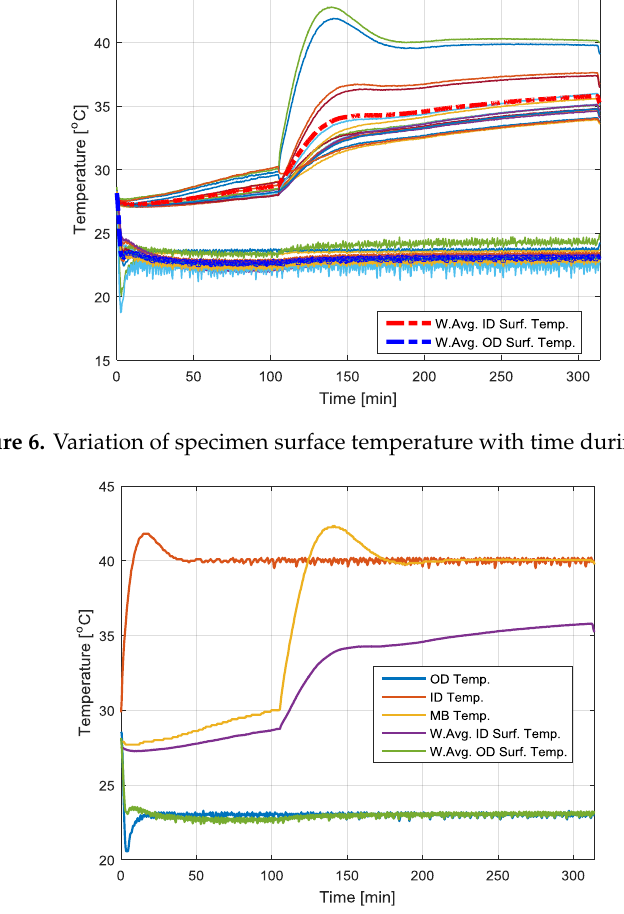
Figure 8. Thermal transmittance of Wall System 1 as a function of the wall mean temperature . ii. Wall System 2 Table 4 shows the results for Wall System 2. As shown in Figure 3b, the wall was composed of a plaster layer of 2.5 cm, a brick layer of 20 cm, and a layer of plaster of 2 cm. Different heat transfer quantities were calculated for different testing days. Figure 9 shows the variation of thermal transmittance of Wall System 2 as a function of the average operating temperature within the wall, generated from various test runs. The changes in the U -value measurements were noted with an average value of around 4.0 W/m 2 K.